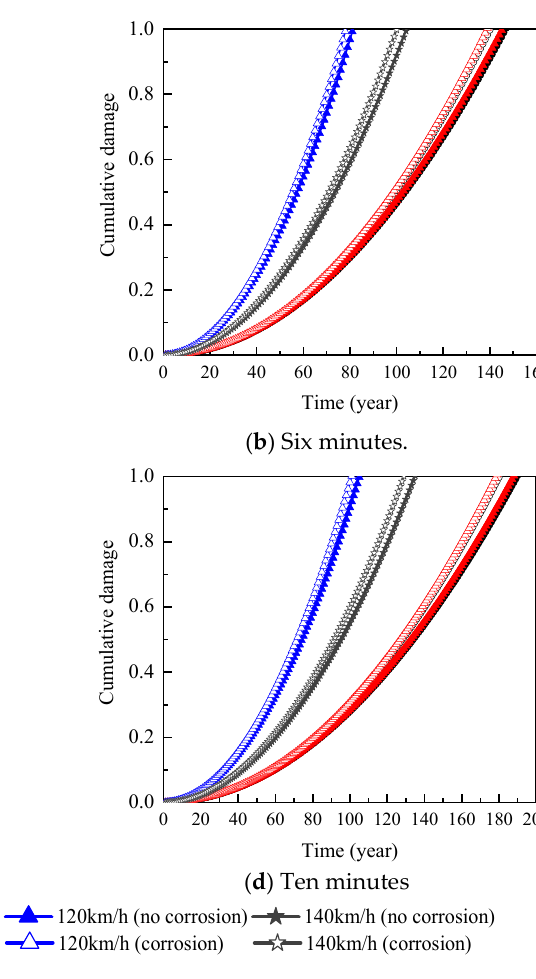
Figure 10. The cumulative damage of 25 m-span bridge.